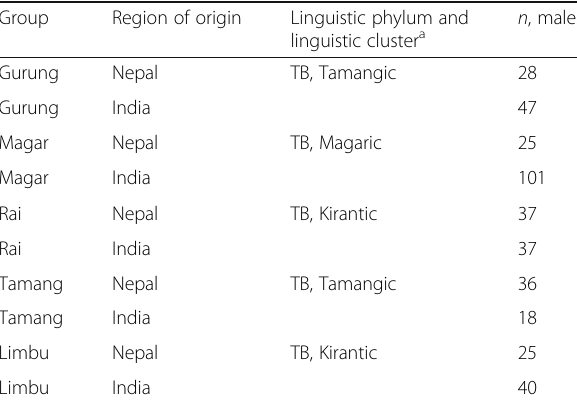
Table 1 Details of participants based on